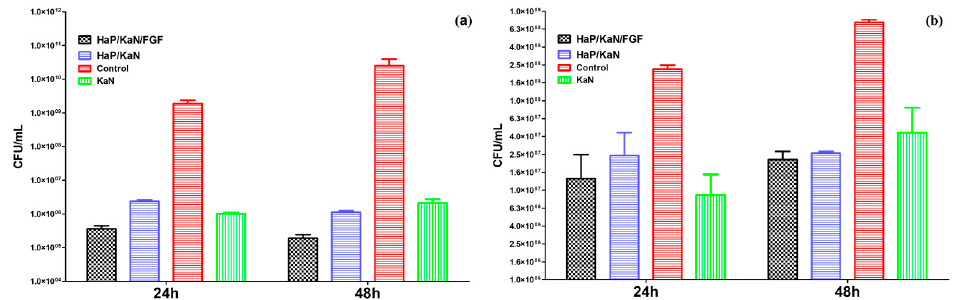
Figure 8. Development of monospecific biofilm of S. aureus ( a ) and Ps. aeruginosa ( b ) after 24 and 48 h of incubation on control and Ti modified with HAp/KAN and HAp/KAN/FGF2 coatings.